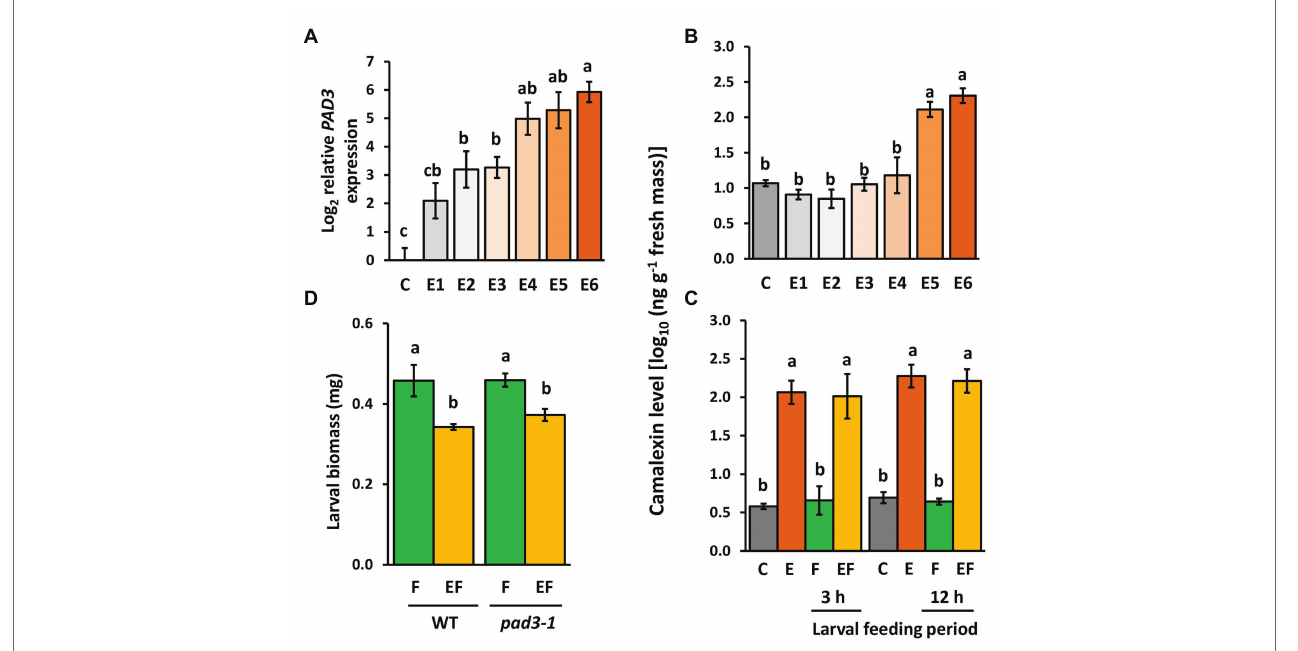
FIGURE 6 | Effect of P. brassicae egg deposition and larval feeding on regulation of camalexin levels in Arabidopsis thaliana . (A) Relative expression of PAD3 (log 2 , mean ± SE) and (B) camalexin levels in egg-free control plants (C) or in plants exposed to eggs for 1 day (E1), 2 days (E2), 3 days (E3), 4 days (E4), 5 days (E5), or 6 days (E6). (C) Camalexin levels in untreated control plants (C), for 6 days egg-laden plants (E) and subsequent egg removal, 3 h or 12 h larval feeding-damaged plants without (F) and with prior egg deposition for 6 days (EF). Concentrations of camalexin are log 10 -transformed in ng g −1 fresh weight (means ± SEM). (D) Biomass in mg (mean ± SE) of P. brassicae larvae that fed on previously egg-laden plants (EF) or egg-free (F) WT and pad3 mutant plants, respectively. Different lowercase letters above the bars indicate significant differences ( p < 0.05, linear mixed model and post hoc general linear hypothesis test with Tukey contrasts). Biological replicates (plants) per treatment: N =